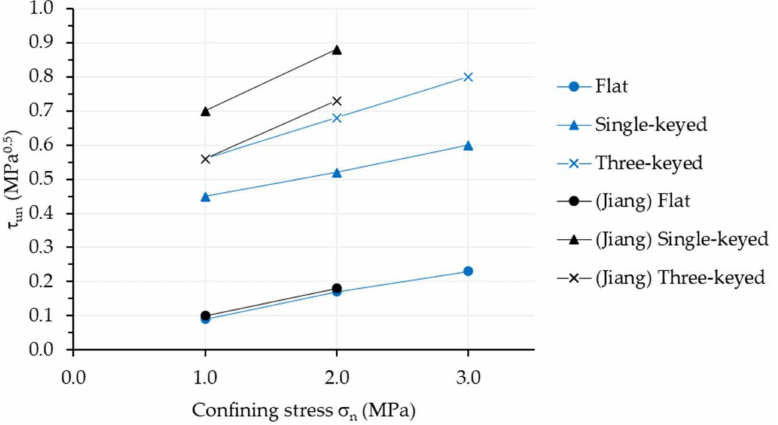
Figure 16. Influence of confining stress on increasing the maximum normalized shear stress of the RAC dry joints and the results of Jiang et al.